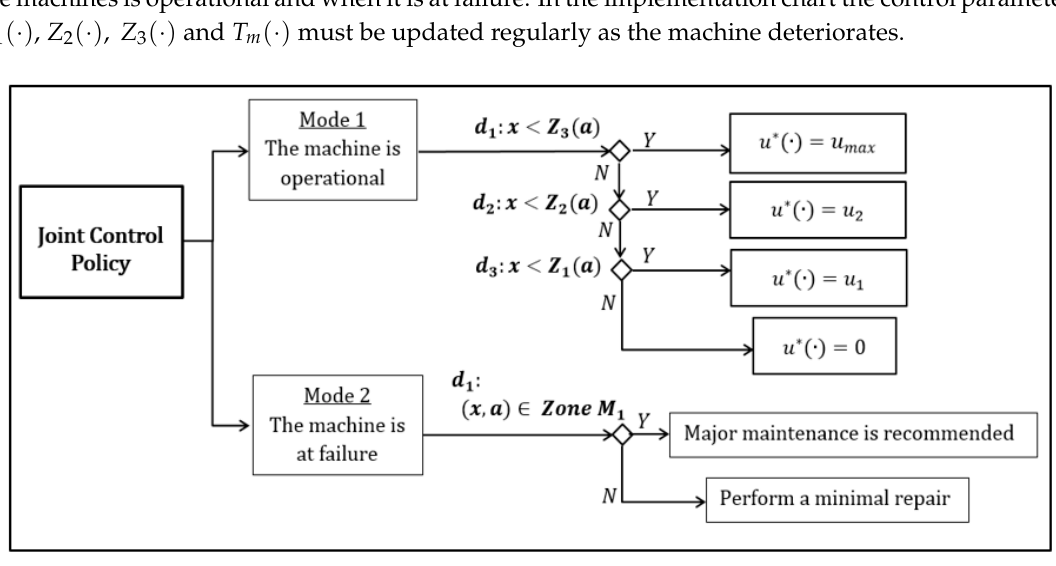
Figure 16. Implementation chart.